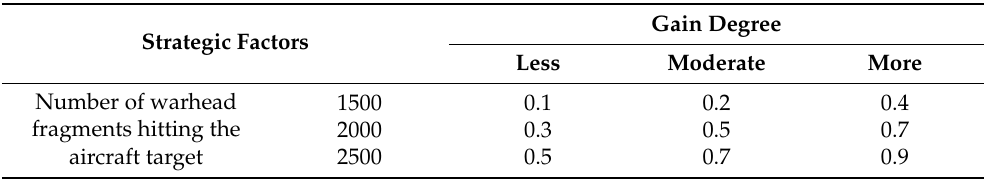
Table 1. The gain degree under different numbers of warhead fragments hitting the aircraft